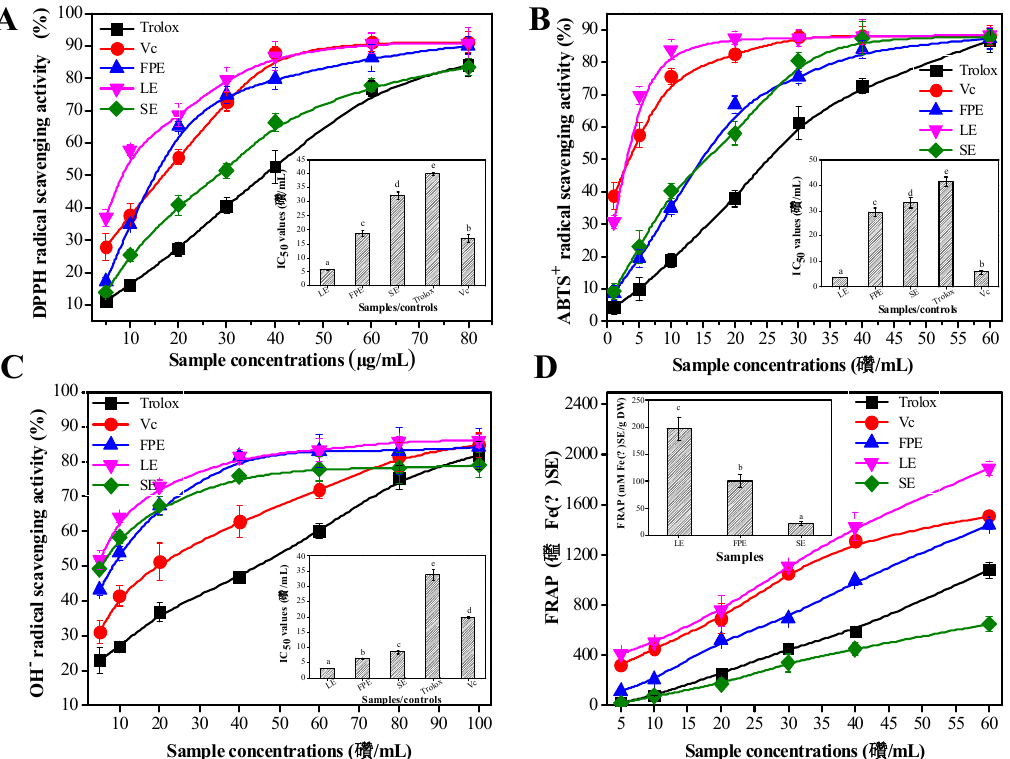
Figure 3. The antioxidant activities of various parts’ extracts of raspberry and the positive controls (Vc and Trolox): DPPH ( A ), ABTS + ( B ), and OH − radical scavenging activity ( C ) and Ferric reducing antioxidant power (FRAP) ( D ). The insets of Figure 3A–D represent the corresponding IC 50 values of the samples/controls. LE, leaves extracts; FPE, fruit pulp extracts; SE, seed extracts. Vc, ascorbic acid. Different lowercase letters (a–e) mean statistically significant differences following different samples.